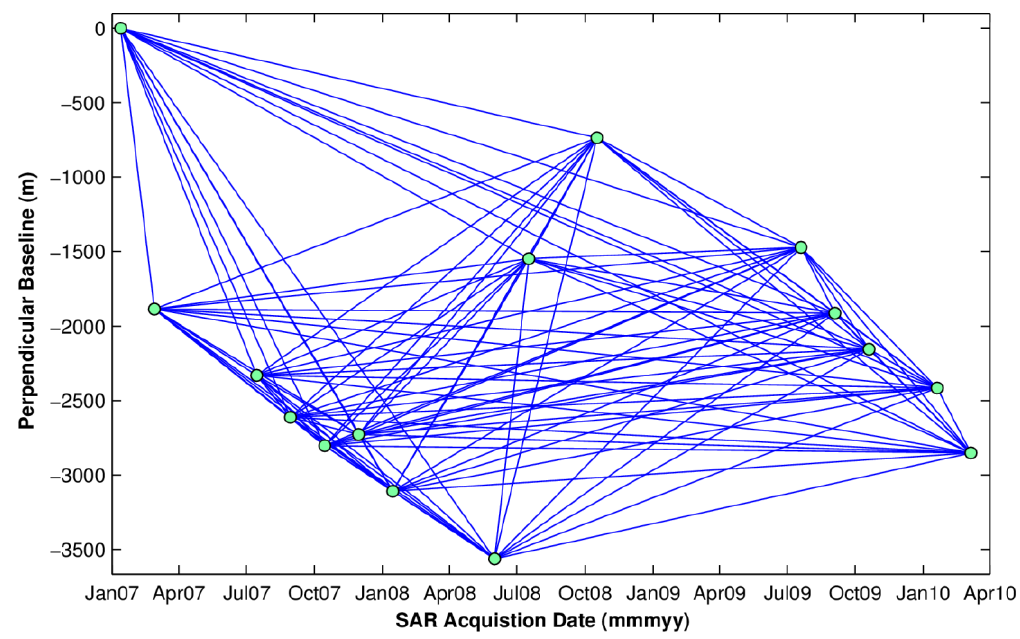
Figure 4. Spatial and temporal baselines of the generated interferograms from 105 combinations.